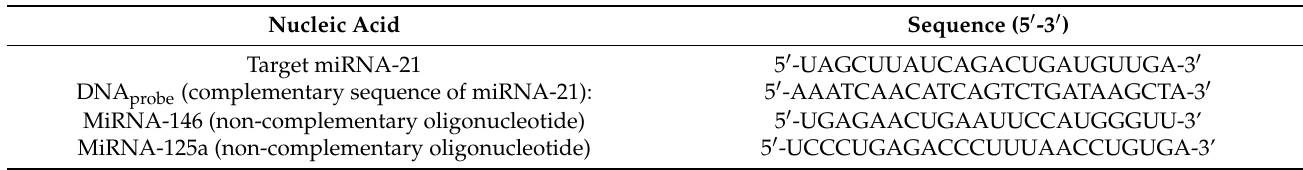
Table 1. Nucleic acids employed in the present work.